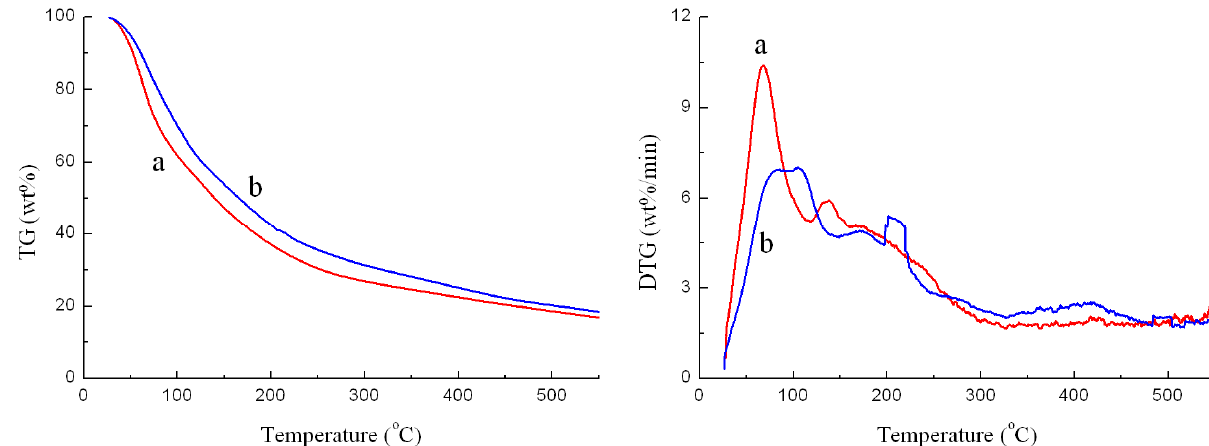
Figure 1. TG and DTG curves of the original BO sample ( a ) and the BO sample after the friction and wear test ( b